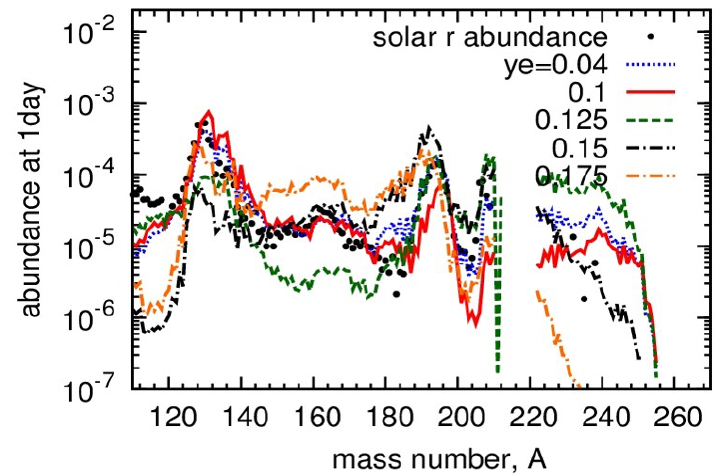
Figure 7. Utilizing the DZ (Duflo-Zucker) mass model [37] one sees large variations of actinide pro- duction as a function of Y e in the ejecta. The highest actinide production takes place for a range of 0.125 to 0.15, decreasing strongly for higher as well as lower Y (cid:48)